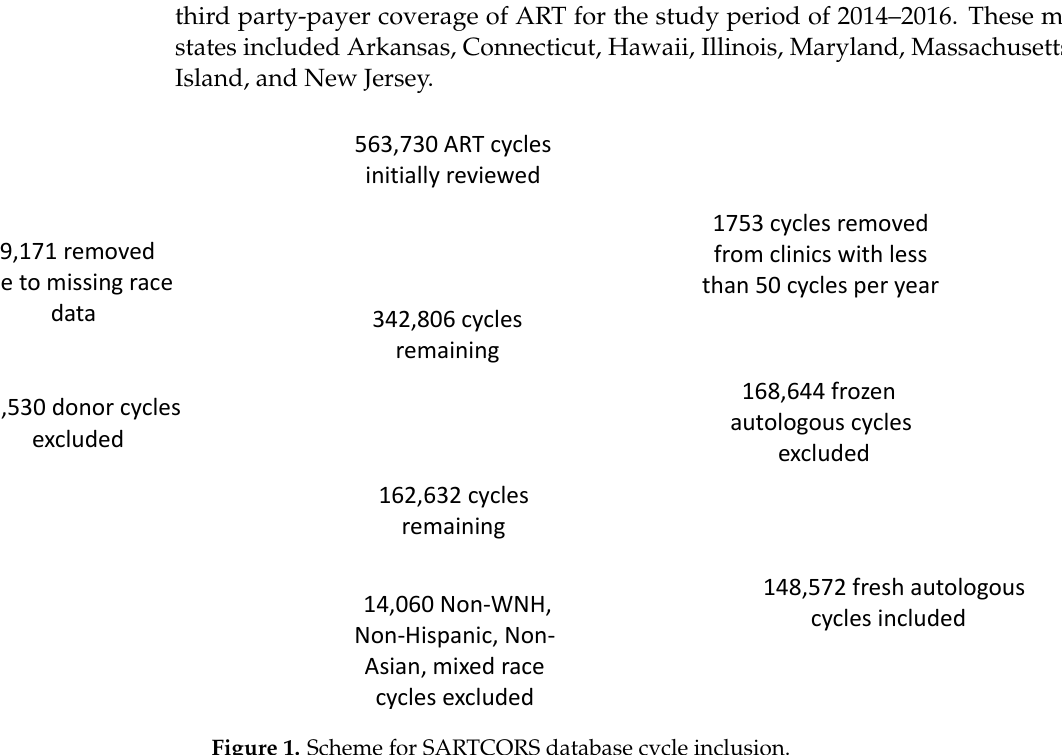
Figure 1. Scheme for SARTCORS database cycle inclusion